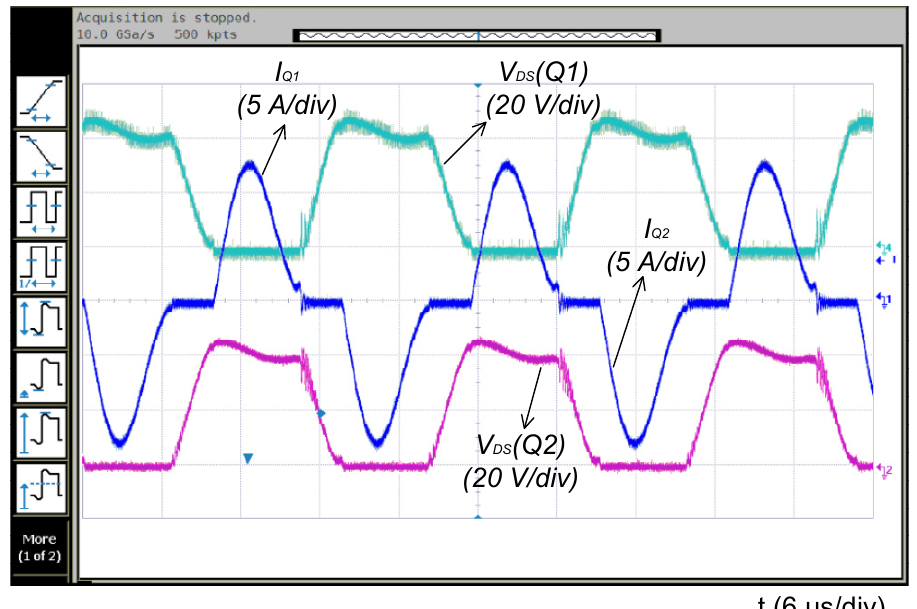
Figure 10. Voltage and current waveforms of the push–pull switches.